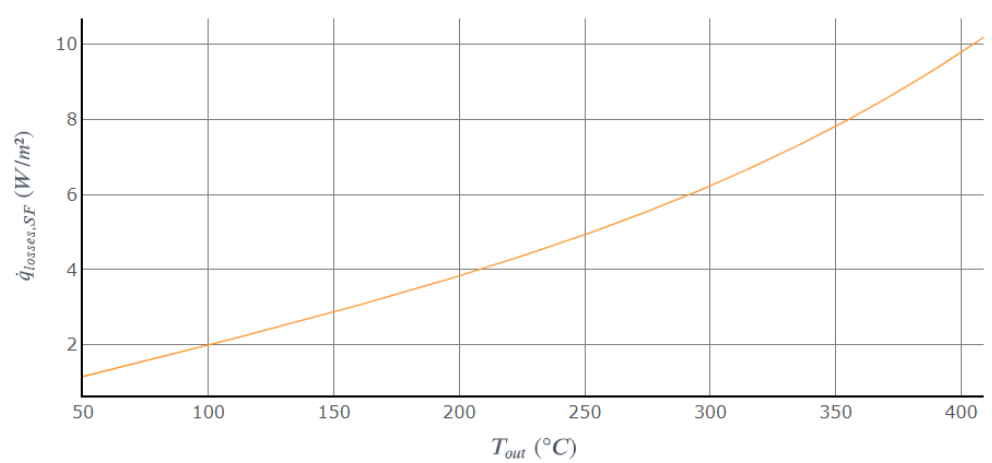
Figure 4. Heat losses in W/m 2 of collector aperture area as a function of the outlet temperature of the LF-11 Fresnel collector,